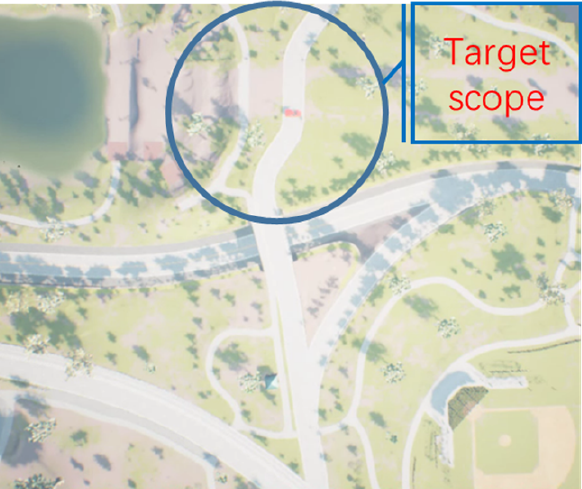
Figure 10. The reward function design method. Outside the target scope, the reward function is calculated by the distance between the target and the UAV. In the target scope, the UAV no longer knows the location of the target but uses a target recognition algorithm to detect the target, from which the reward is calculated .